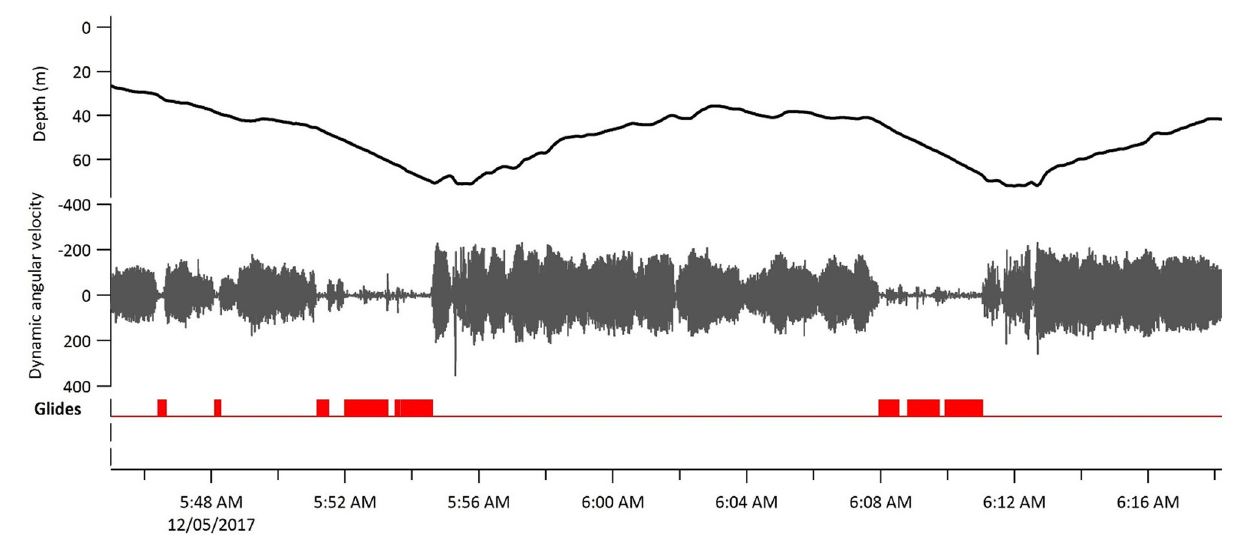
FIGURE 2 | Gliding behavior in a tagged sandbar shark (Shark 3) over the course of ∼ 30min. Dynamic angular velocity was taken from the lateral (sway) axes recorded by the gyroscope. Glides are marked where the mask analysis determined gliding was occurring.